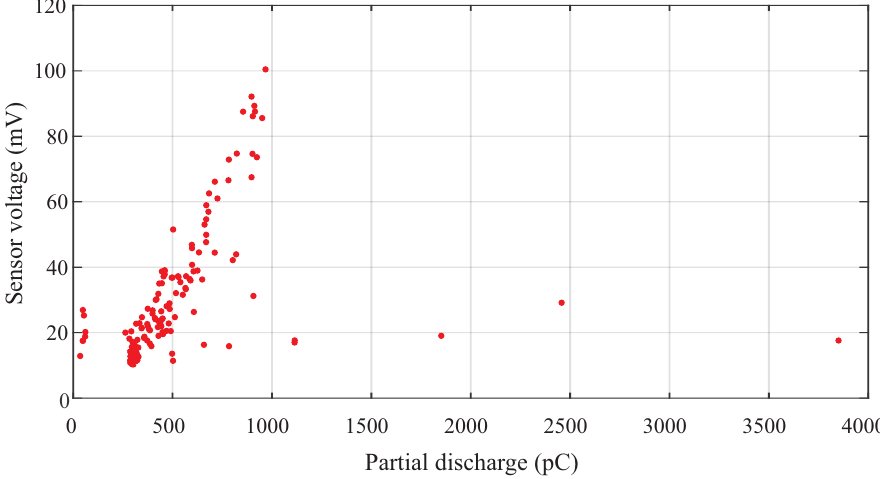
Figure 17. Correlation between the PD signal detected by the UHF sensor and the IEC 60270 standard method for the distance of 1 m between the UHF sensor and the PD source.